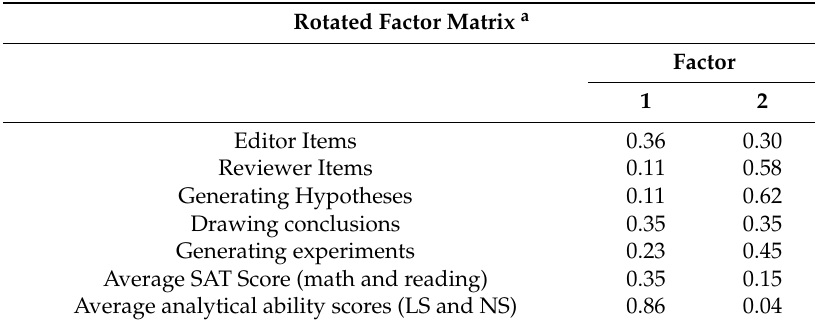
Table 20. Rotated factor matrix in the Study 2 maximum likelihood factor analysis of the total scores of all our subscales with exception of the editor items, and the analytical ability tests and SAT. Rotated Factor Matrix a Factor 1 2 Reviewer Items 0.12 0.52 Generating Hypotheses 0.12 0.73 Drawing conclusions 0.34 0.35 Generating experiments 0.17 0.42 Average SAT Score (math and reading) 0.33 0.19 Average analytical ability scores (LS and NS) 0.97